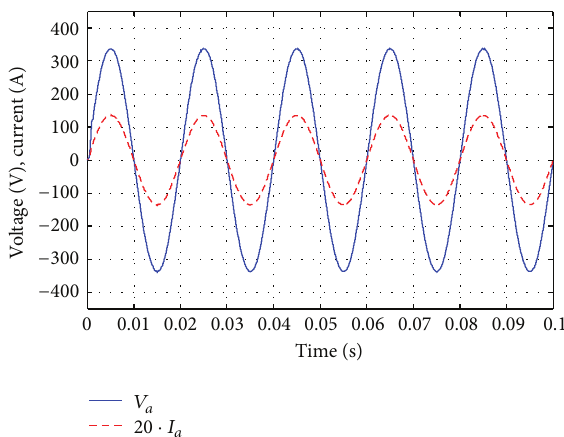
Figure 15: Output voltage (𝑉 𝑎 ) and current load (𝐼 𝑎 ) of the inverter with 𝑅